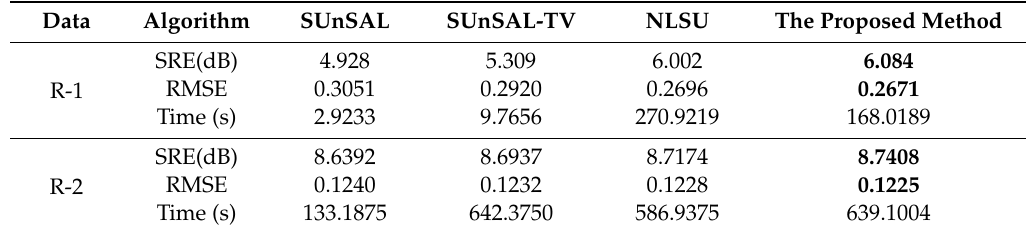
Table 2. Performance comparison for the di ff erent methods with the two real hyperspectral datasets.